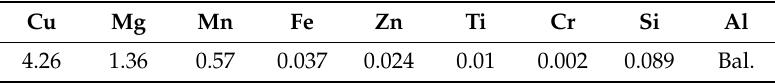
Table 1. Main chemical composition of Al–Cu–Mg alloy (mass fraction,